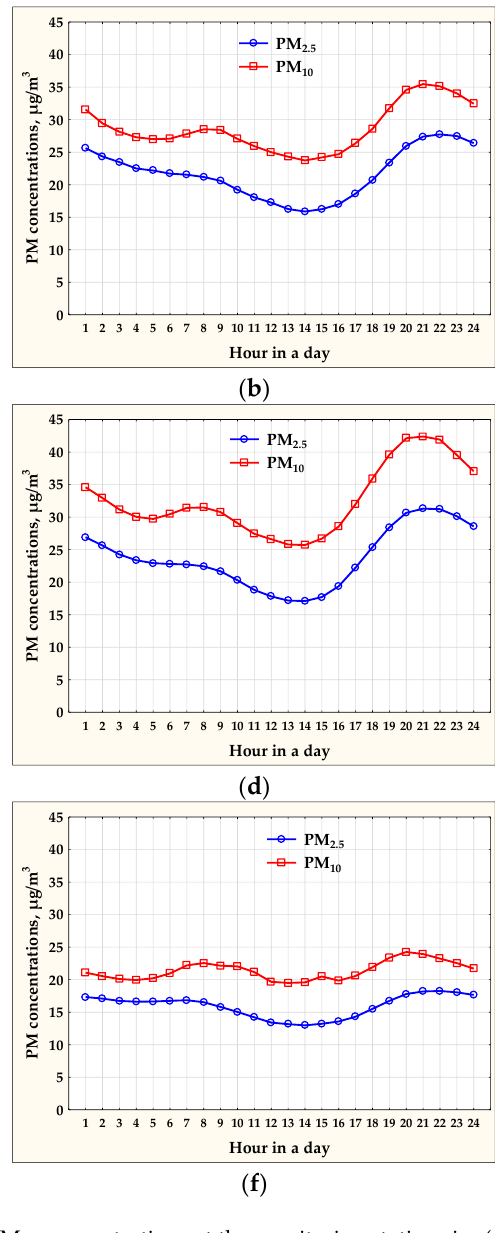
Figure 5. Diurnal courses of PM 2.5 and PM 10 concentrations at the monitoring stations in: ( a ) Jelenia Gora; ( b ) Lublin; ( c ) Plock; ( d ) Radom; ( e ) Kedzierzyn-Kozle; ( f ) Olsztyn.